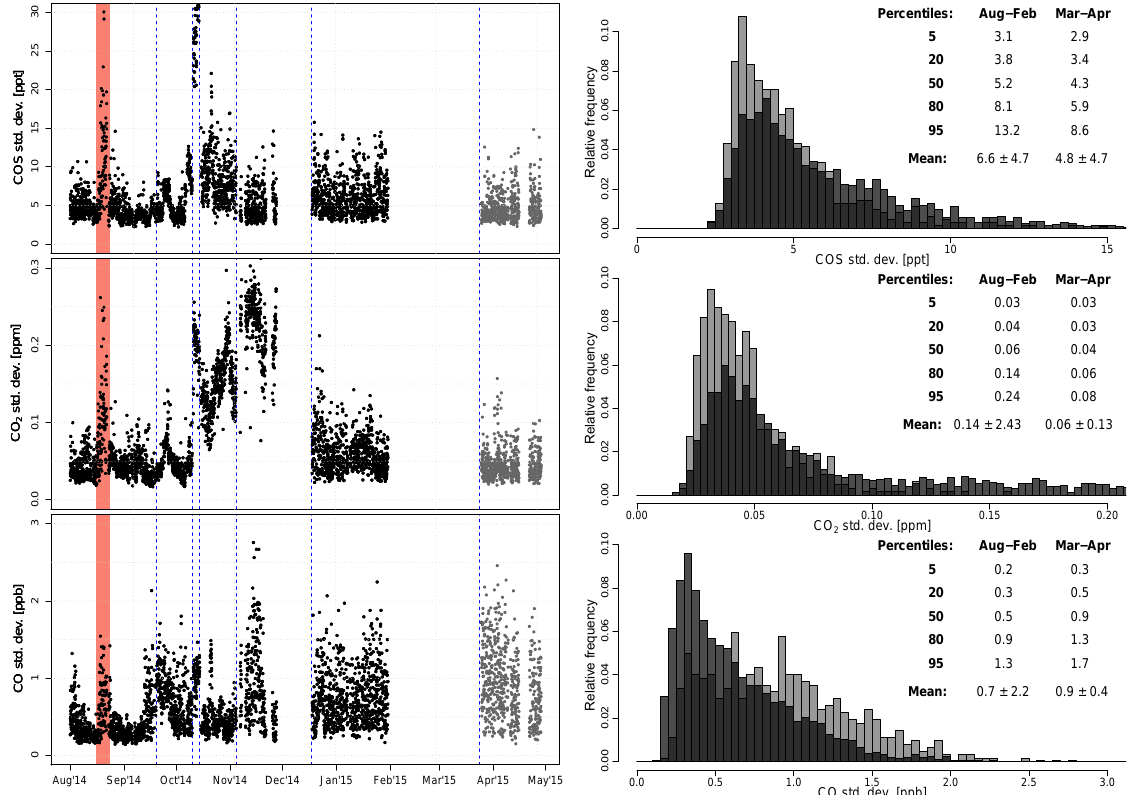
Figure 6. Left: standard deviation over 2min of hourly measurements of one of the working standards as measured from August 2014 until April 2015. The gray (black) colored data indicate the period after (before) modifications were made to improve the temperature stability (such that T electr varied with 0.21 ◦ C with every degree of changing T room , against 0.91 ◦ C ◦ C − 1 before modifications; see Sect. 2.5). For the period that is marked with a red background the room temperature was characterized by rapid changes caused by an air conditioner. Blue vertical (dashed) lines indicate moments where the mirror alignment was changed. Right: histogram of standard deviations as shown in the left figure with the black/gray colors corresponding to the colors in the left figure. Note that the dark histogram is transparent. Also included are the mean standard deviations as well as an overview of percentiles because the data do not show a Gaussian distribution.